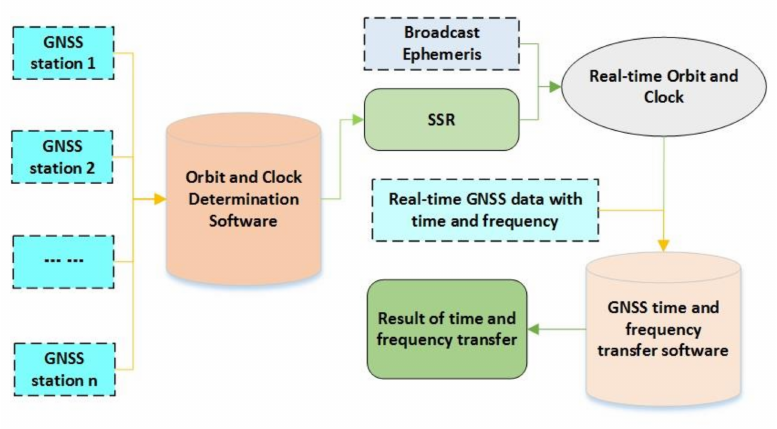
Figure 1. Prototype system of real-time multi-GNSS time transfer